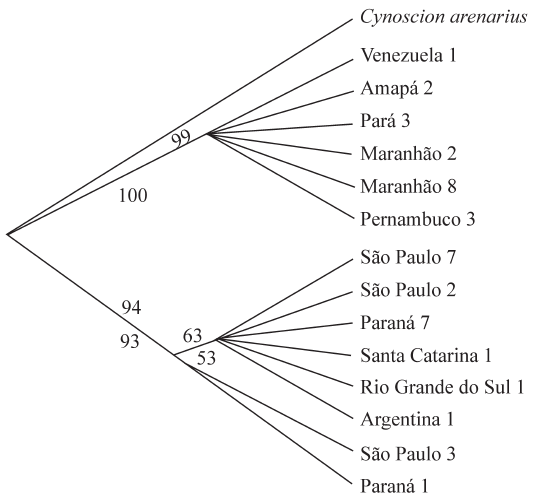
Figure 5 - Phylogenetic tree for Macrodon populations based on 520 base pairs of 16S rRNA. When above 50%, numbers in the nodes indicate the percentage of trees out of 1000 bootstrap replicates for the maximum- parsimony (MP, above) and neighbor-joining (NJ, bellow) trees. Cynoscion arenarius was used as